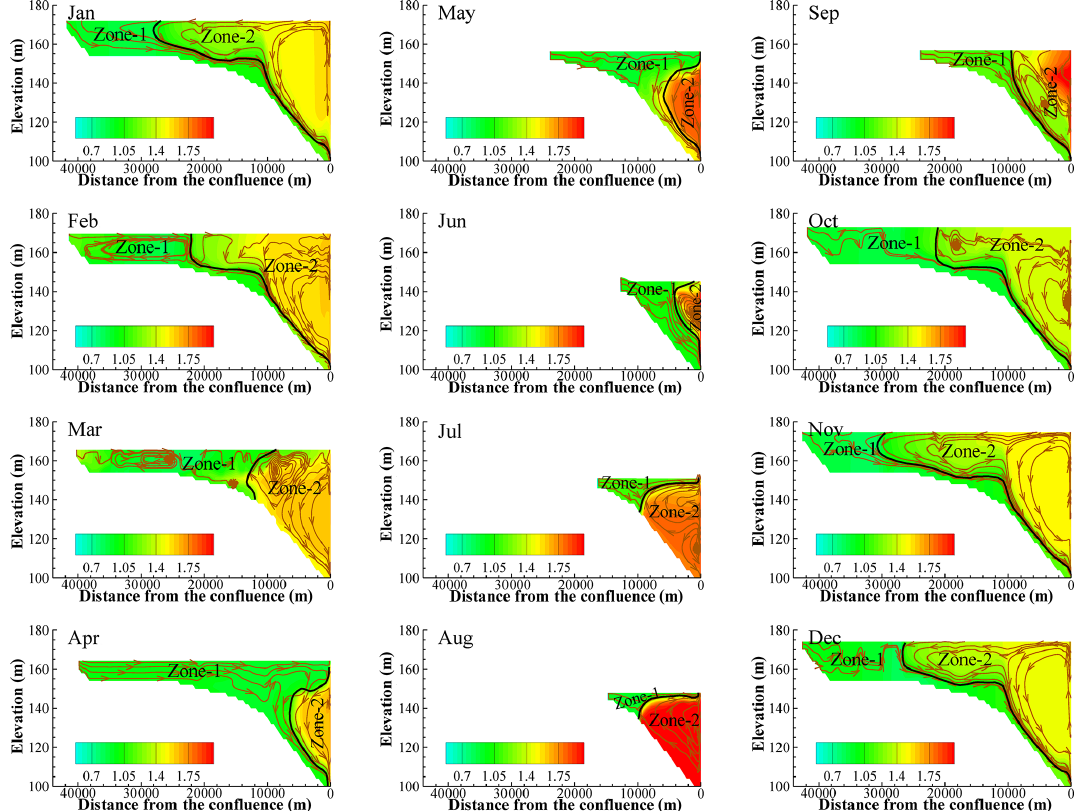
Figure 14. Distribution of TN in each month. The black curve in the figure is the boundary between zone 1 and zone 2. The brown curves with arrows are streamlines.